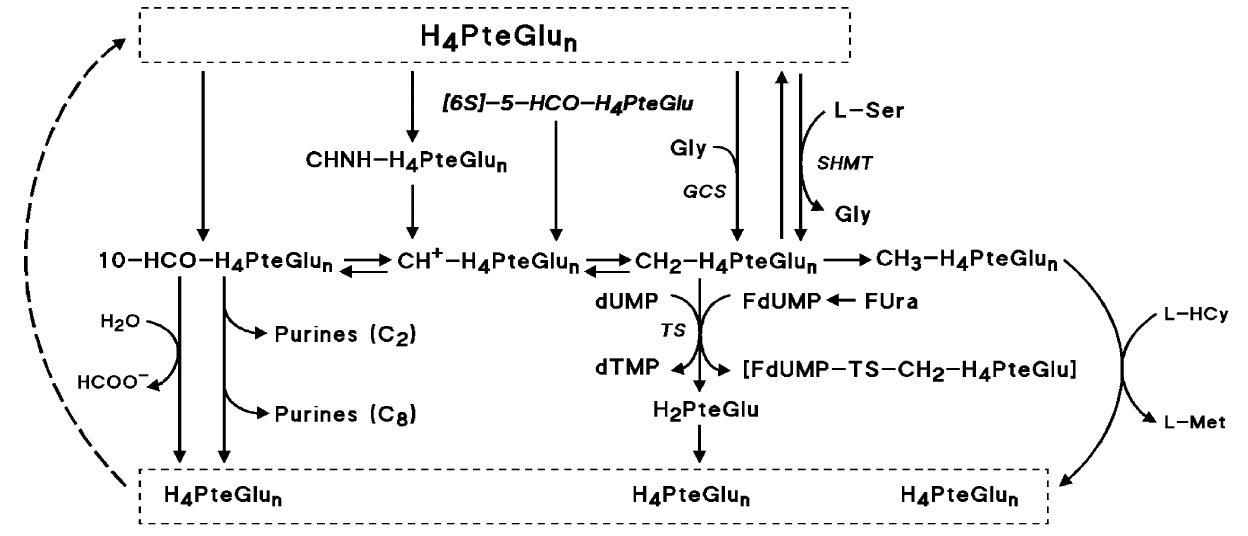
Figure 1. Selected pathways of folates, and FdUMP-mediated thymidylate synthase inhibition. Folates H 2 PteGlu: 7,8-di hydro pteroylglutamate; H 4 PteGlu: 5,6,7,8-tetra hydro pteroylglutamate; CH 2 -H 4 PteGlu: 5,10-methylene tetra hydro pteroylglutamate; CH 3 -H 4 PteGlu: 5-methyl tetra hydro pteroylglutamate; CH + -H 4 PteGlu: 5,10-methenyl tetra hydro pteroylglutamate; 10-HCO-H 4 PteGlu: 10-formyl tetra hydro pteroylglutamate; CHNH-H 4 PteGlu: 5-formimino tetra hydro pteroylglutamate; [6S]-5-HCO-H 4 PteGlu: [6S]-5-formyl tetra hydro pteroylglutamate ([6S]-folinic acid). Enzymes TS, thymidylate synthase; SHMT, serine hydroxymethyltransferase (pyridoxal 5’-phosphate-dependent enzyme, including the cytoplasmic SHMT1 and the mitochondrial SHMT2 isoforms); GCS, glycine cleavage system (mitochondrion). Other compounds and substances involved in TS inhibition dUMP, deoxy uridine monophosphate; dTMP, thymidine monophosphate; L-Ser, L-serine; Gly, glycine; L-HCy, L-homocysteine; L-Met, L-methionine; HCOO - , formate; FUra, 5-fluorouracil; FdUMP, fluorodeoxyuridine monophosphate; [FdUMP-TS-CH 2 -H 4 PteGlu], the ternary complex resulting in inhibition of